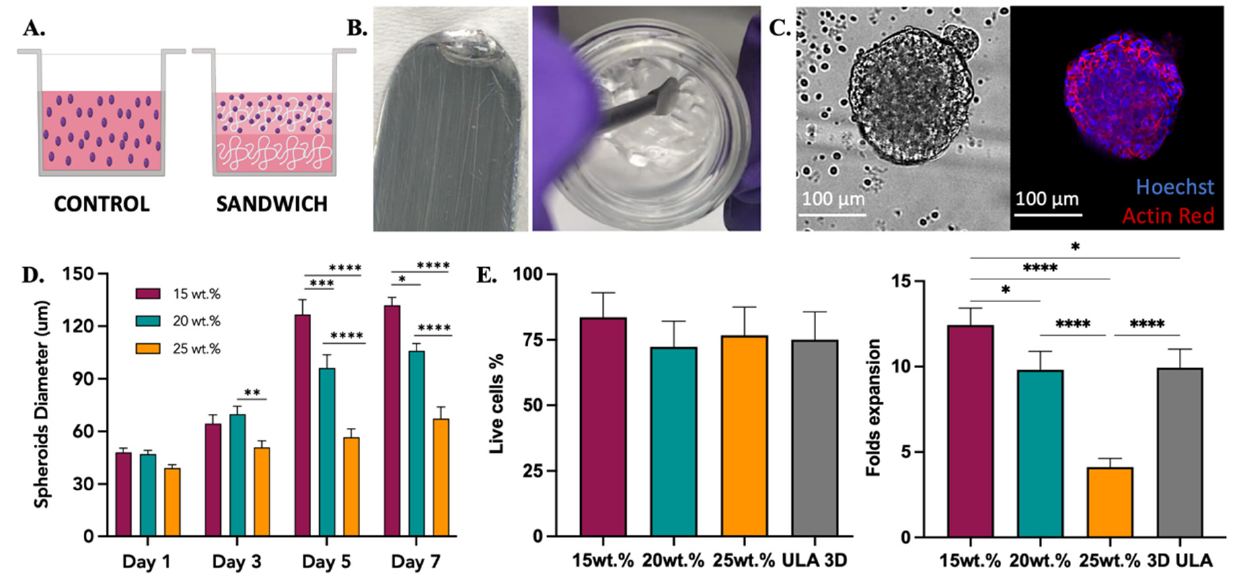
Figure 5. SKOV-3 cell culture testing with 2:4:94 P400 terpolymer combination. ( A ) Conditions employed to test terpolymer scaffolds with SKOV-3 cell culture. Control: Cells in the same working volume as other conditions. Sandwich: Mixing of cells with terpolymer seeded on top of a terpolymer coating. SKOV-3 cells were tested with 2:4:94 P400 terpolymer using the sandwich condition. ( B ) Transparency of 2:4:94 P400 terpolymer combination. ( C ) Brightfield and merge fluorescence pictures of SKOV-3 cells after 10 days of culture. 2D Control ( right side) and spheroid growth ( left side) inside 15 wt.% terpolymer scaffolds. The blue color represents the nucleus of cells, while the red color represents the cytoskeleton, which was stained with Hoechst and Actin Red staining solutions, respectively. Scale bar: 100 µ m. ( D ) The general trend of encapsulated spheroids size over the days 1, 3, 5, and 7 of cultivation inside 15, 20, and 25 wt.% terpolymer scaffolds. ( E ) Cell viability and live cell fold expansion of harvesting after 7 days of encapsulation. The graphs show means and STDV values of n = 6 spheroids, except for cell viability which expresses error propagation. p -values: blank (not significant), 0.0078 (*), 0.0057 (**), 0.0003 (***), <0.0001